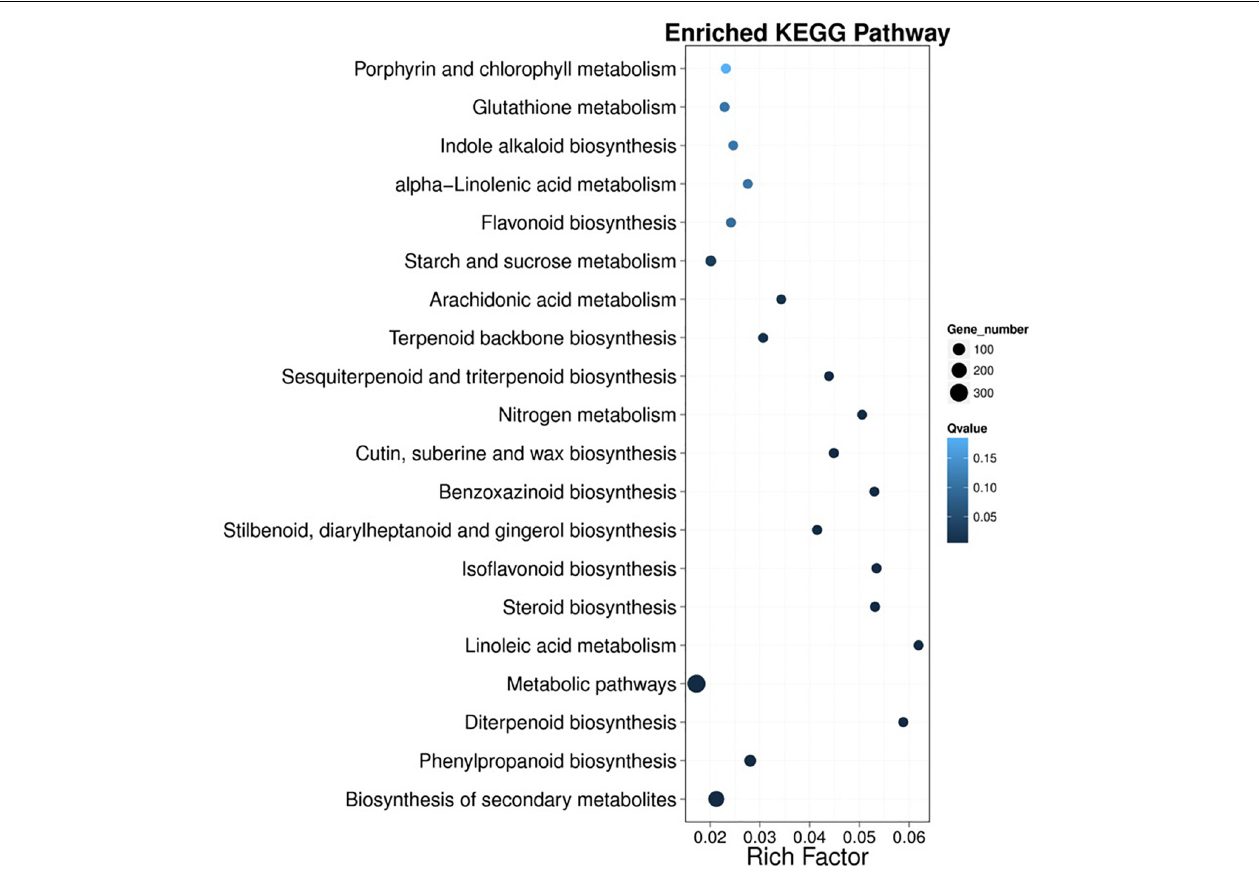
FIGURE 4 | Kyoto Encyclopedia of Genes and Genomes (KEGG) enrichment analysis of DEGs identified in wheat. The x -axis represents the enrichment factor. The y -axis represents the pathway name. The richness factor refers to the value of the enrichment factor, which is the ratio of the number of DEGs to the total number of DEGs. The larger the value is, the more significant the